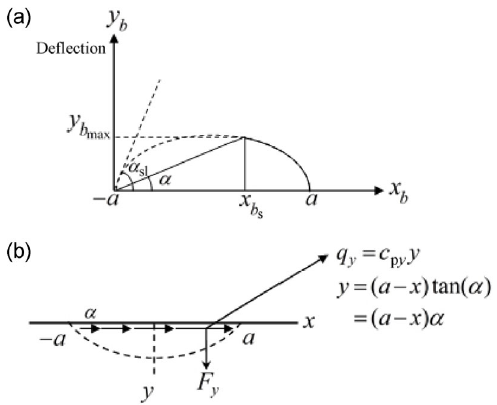
Fig. 15 Schematic of the contact patch: (a) load distribution and (b)